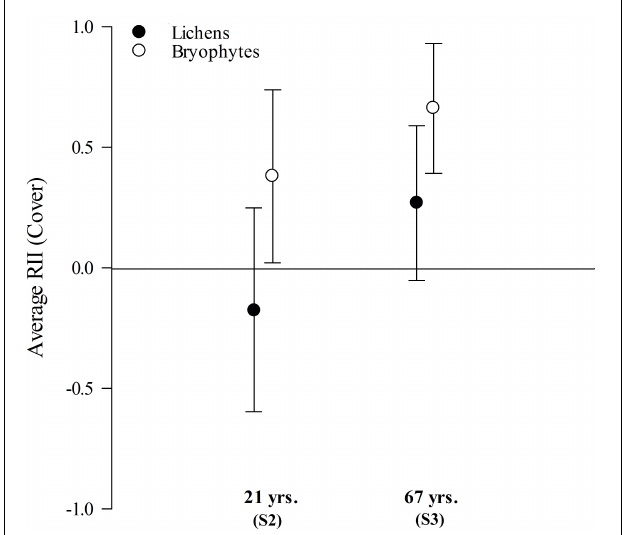
FIGURE 6 | Mean relative interaction index (RII) and 95% confidence interval for the total cover of lichens (black circles) and bryophytes (white circles) in paired sampled in rings ( n = 40) centered on mature individuals of the pioneer grass Poa petrosa vs. random sites outside, in two study sites (S2-S3) along a post-glacial chronosequence (21 and 67 years) at Humboldt Peak,